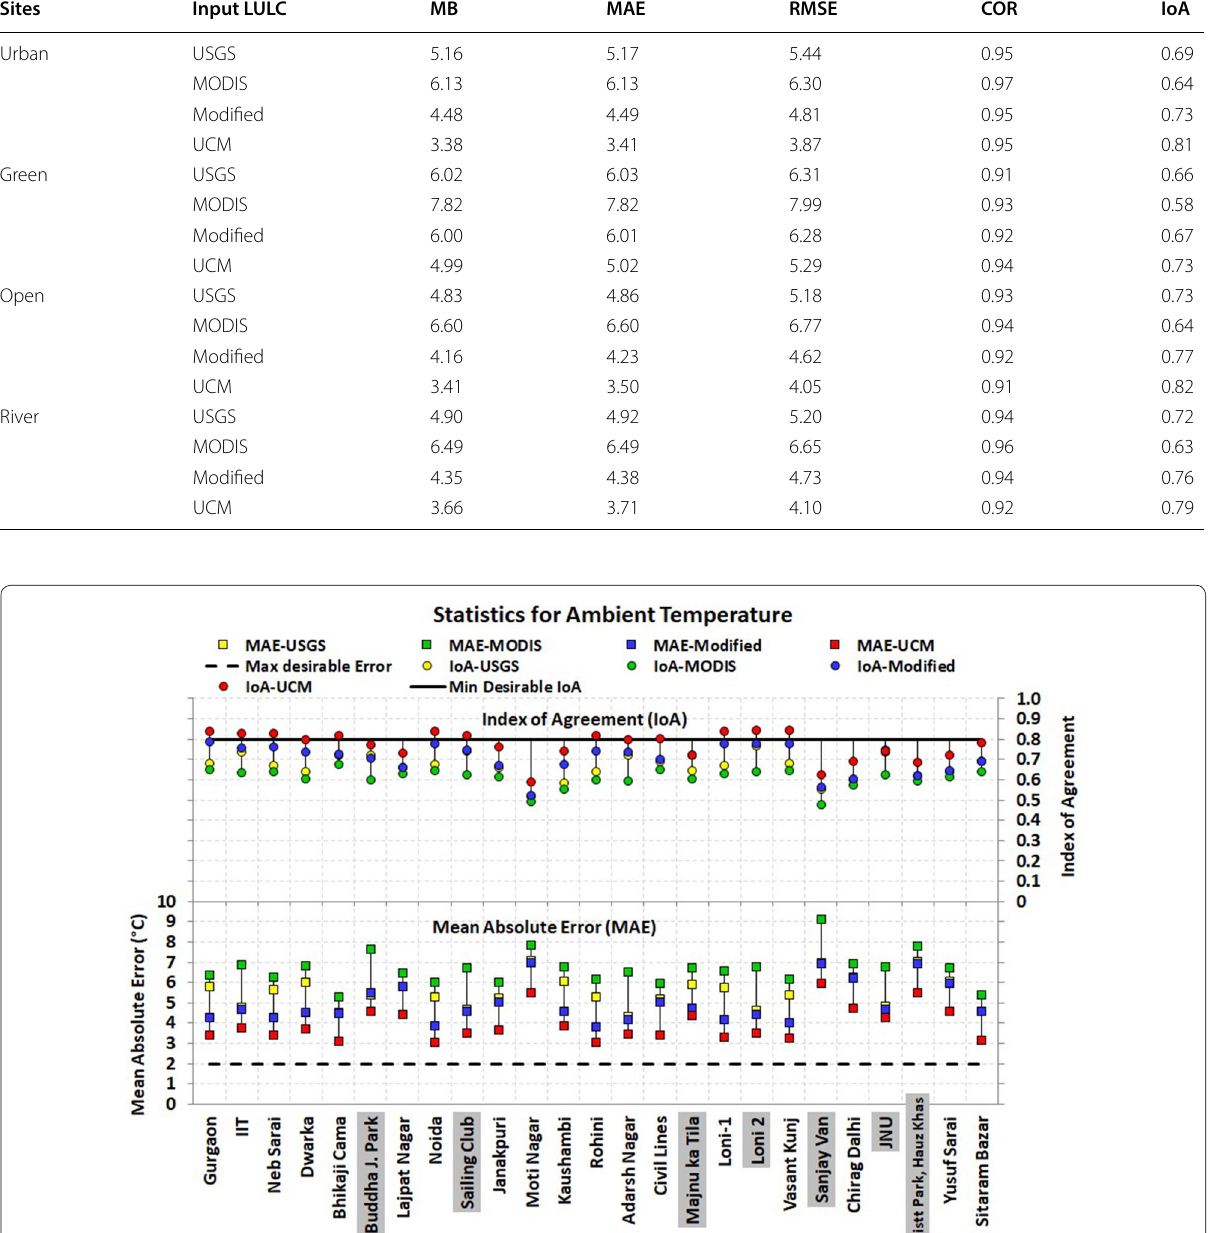
Table 2 Statistical evaluation of WRF model performance for temperature for different types of observation sites Sites Input LULC MB MAE RMSE COR IoA Urban USGS